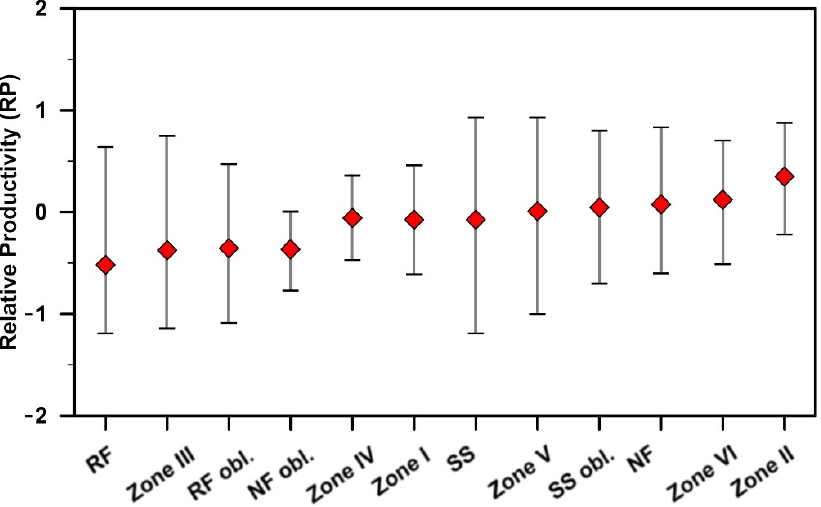
Figure 8. Relative aftershock productivity (RP) in relation to the style of faulting classification (RF, SS, NF, RF oblique, SS oblique, NF oblique) and according to the zonation scheme of this study (Zones I–VI). Red diamonds represent the median RP-value, and the caps denote the extent of calculated RP-values.